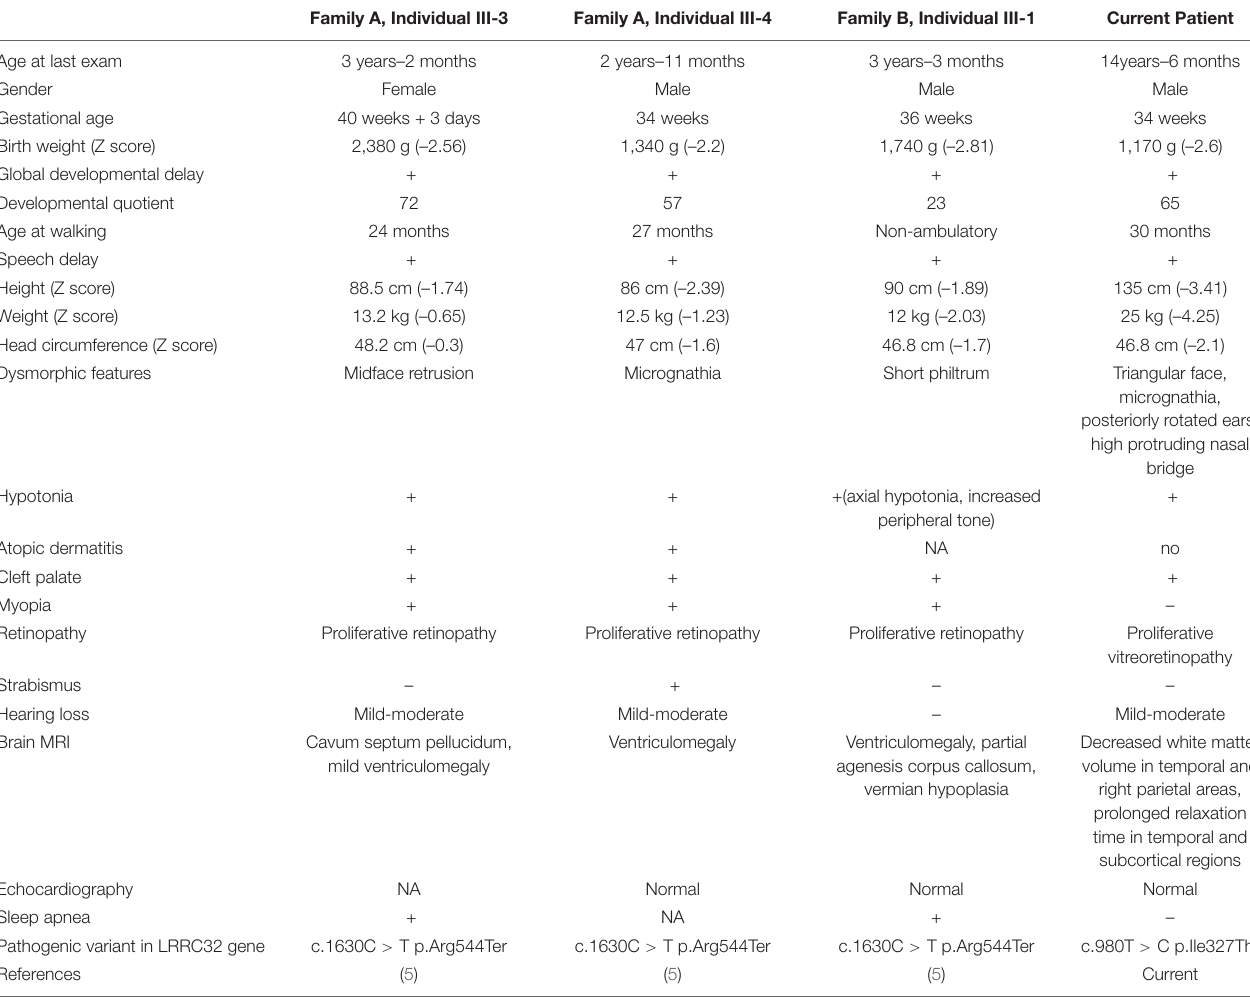
TABLE 1 | Clinical and genetic characteristics of patients with cleft palate and retinopathy syndrome associated with LRRC32 pathogenic variants. Family A, Individual III-3 Family A, Individual III-4 Family B, Individual